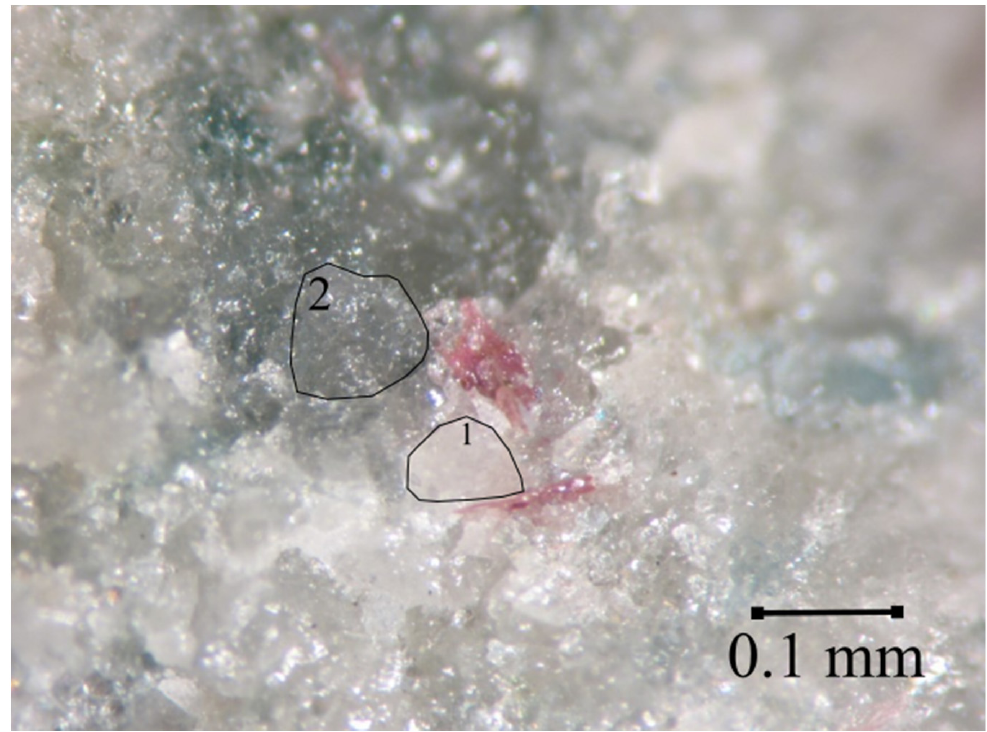
Figure 1. Subhedral pale pink zoisite-(Pb) associated to calcite (1), celsian (2), and vesuvianite (bluish green). Collection Museo di Storia Naturale, University of Pisa (holotype specimen, catalogue number 19,927).